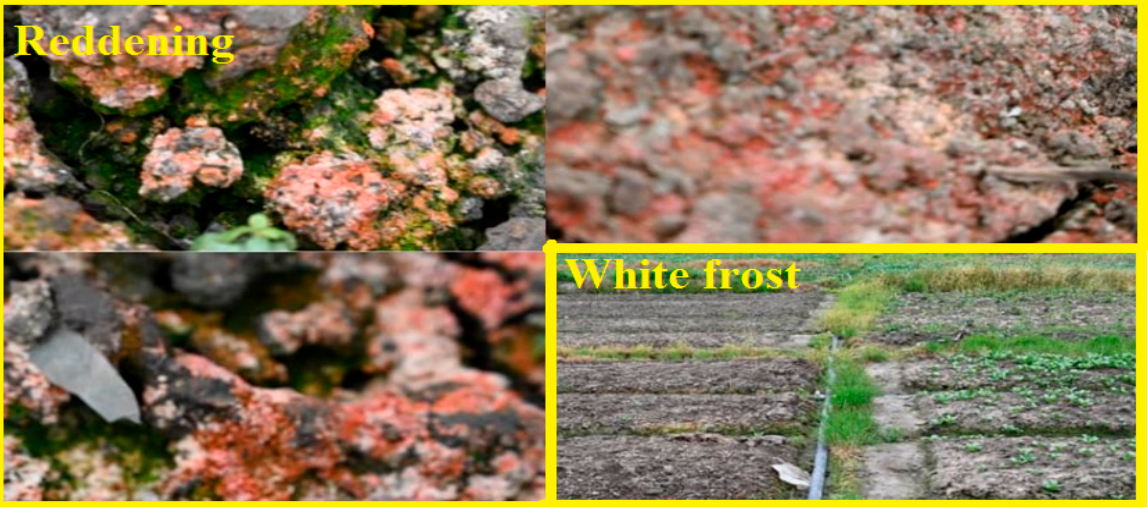
Figure 3. Salinization with different salt contents as surface characteristics on soil surface (Picture taken by Xiaoqing Qian, 2022).